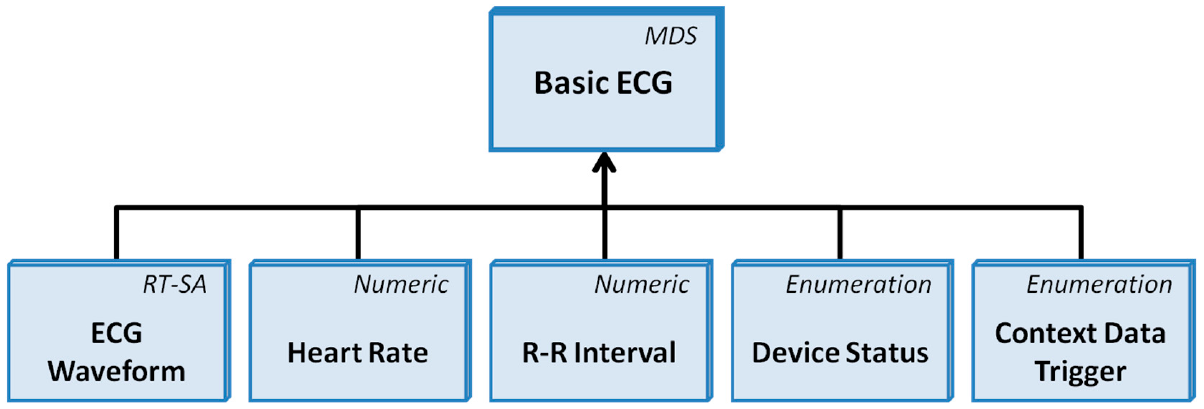
Figure 5. Representation of the different object classes in the ISO/IEEE 11073 ‐ 10406 Basic ECG device specialization.